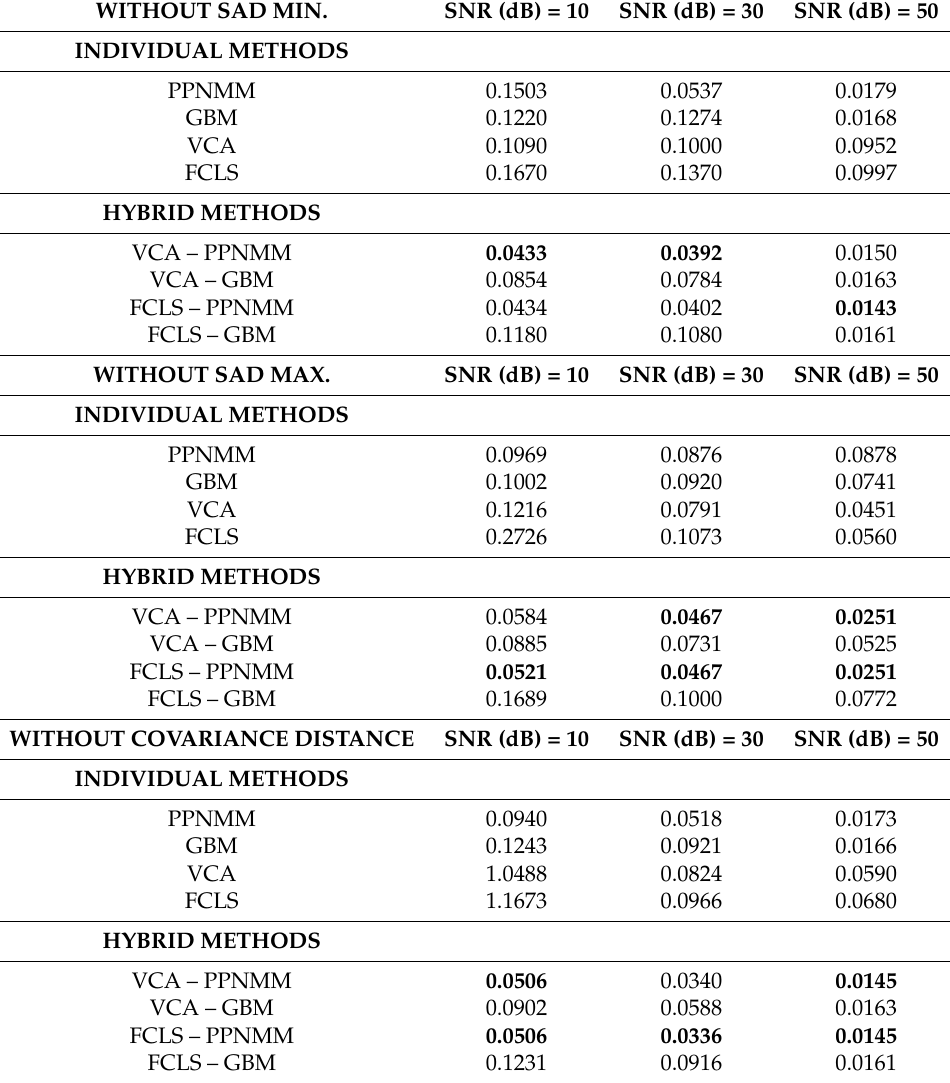
Table 2. Abundance estimation error (3 × 3 window) of the individual and hybrid methods between linear and nonlinear spectral unmixing with different signal to noise ratios and 3 endmembers where each of the parameters is removed one at a time. The best results are shown in bold. WITHOUT SAD